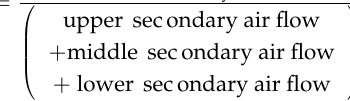
. Figure 8. Influence of k m on C NOx . Notes: k m =